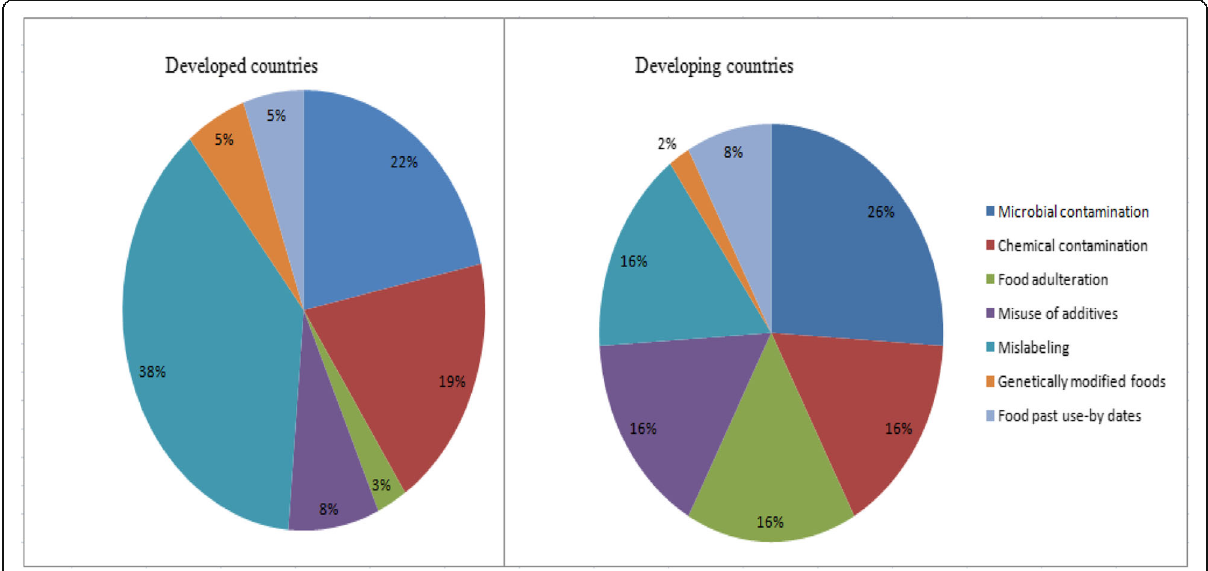
Fig. 3 Comparison of food safety issues in developed and developing